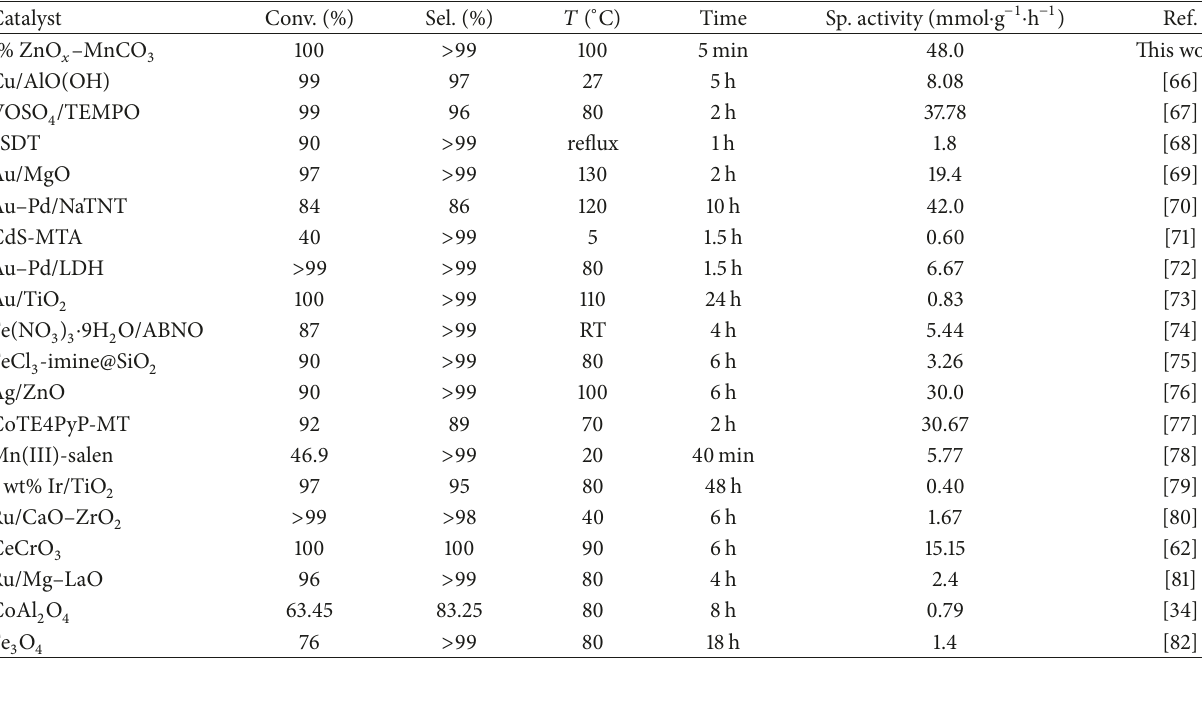
Table 5: A comparison between performance of our catalytic system and earlier reported catalysts for 1-phenylethanol oxidation. Catalyst